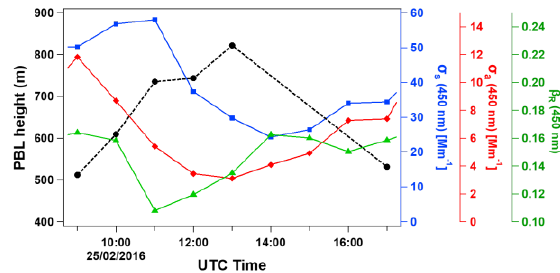
Figure 5 Temporal evolution of the hourly means of PBL height from the RCS-SD (black dots), aerosol scattering σ s and absorption σ a coefficient at 450 nm (blue boxes and red diamonds, respectively), and backscatter ratio β R at 450 nm (green triangles) on 25 February 2016.